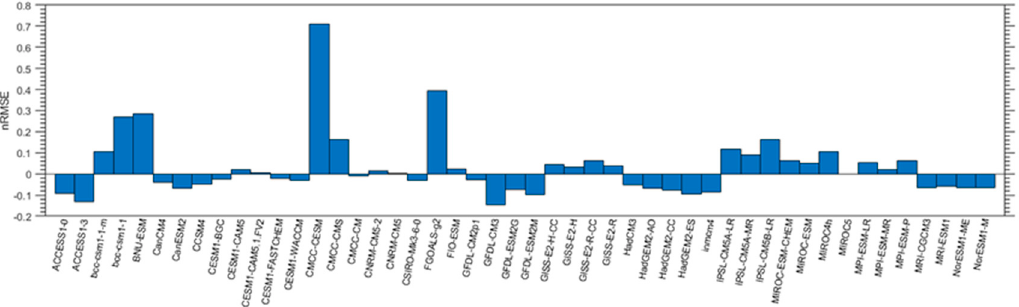
Figure 4. Normalized root mean squared errors (nRMSEs) of monthly SSR estimated from GCMs from 2000 to 2005.